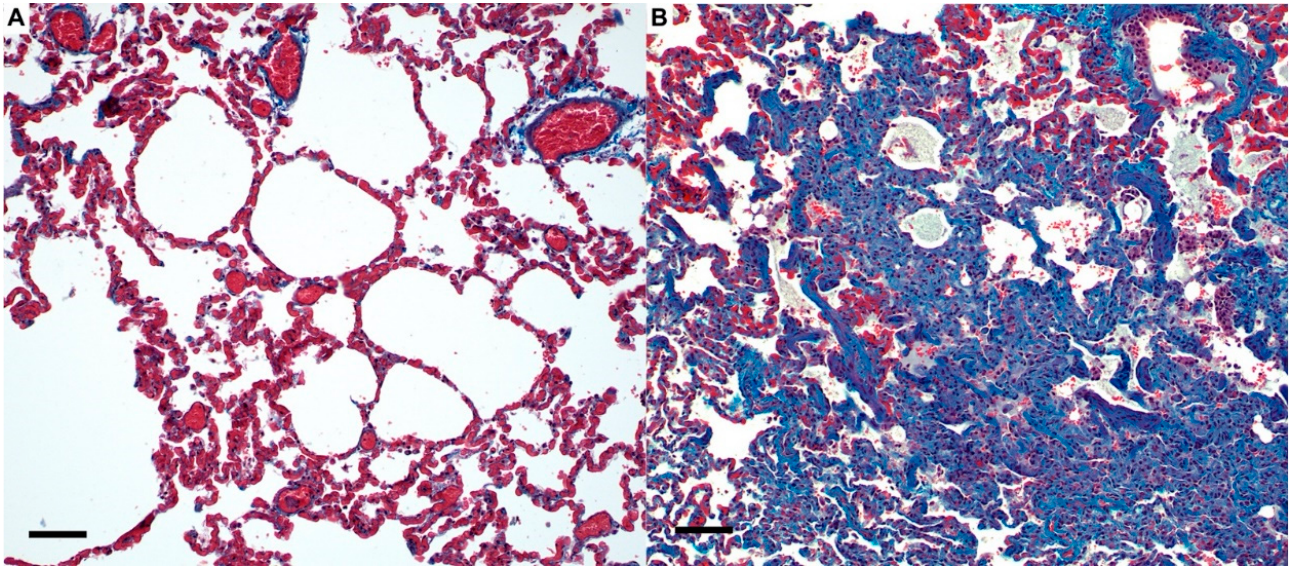
Figure 3. Masson’s trichrome stain of lungs during SARS-CoV-2 infection in domestic cats. ( A ) Normal lung from sham-inoculated cats exhibiting minimal amounts of collagen (blue) present within the interstitium and surrounding vascular structures. ( B ) In SARS-CoV-2 infected cats (12 dpi), alveolar septa are expanded by large amounts of collagen (blue) and proliferating fibroblasts that are strongly associated with areas of inflammation. Magnification 20×, scale bar = 50 µm.